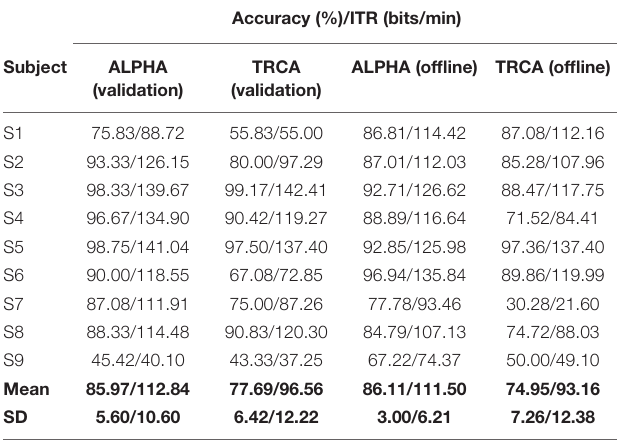
TABLE 3 | Result comparison of the validation experiment and offline